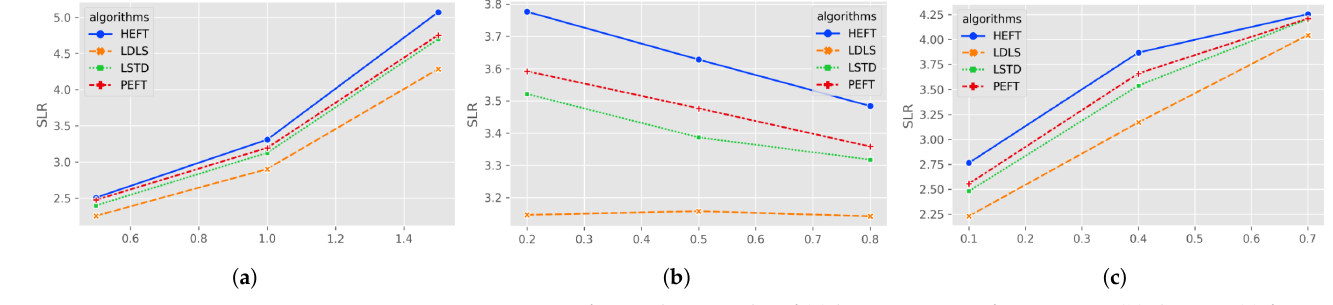
Figure 2. Average SLR for random graphs of ( a ) heterogeneity of processors; ( b ) density; ( c )